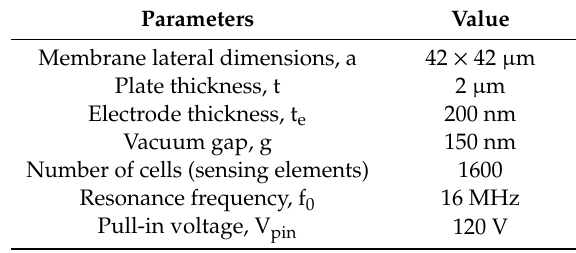
Table 2. Parameters of manufactured CMUT device chips [59].